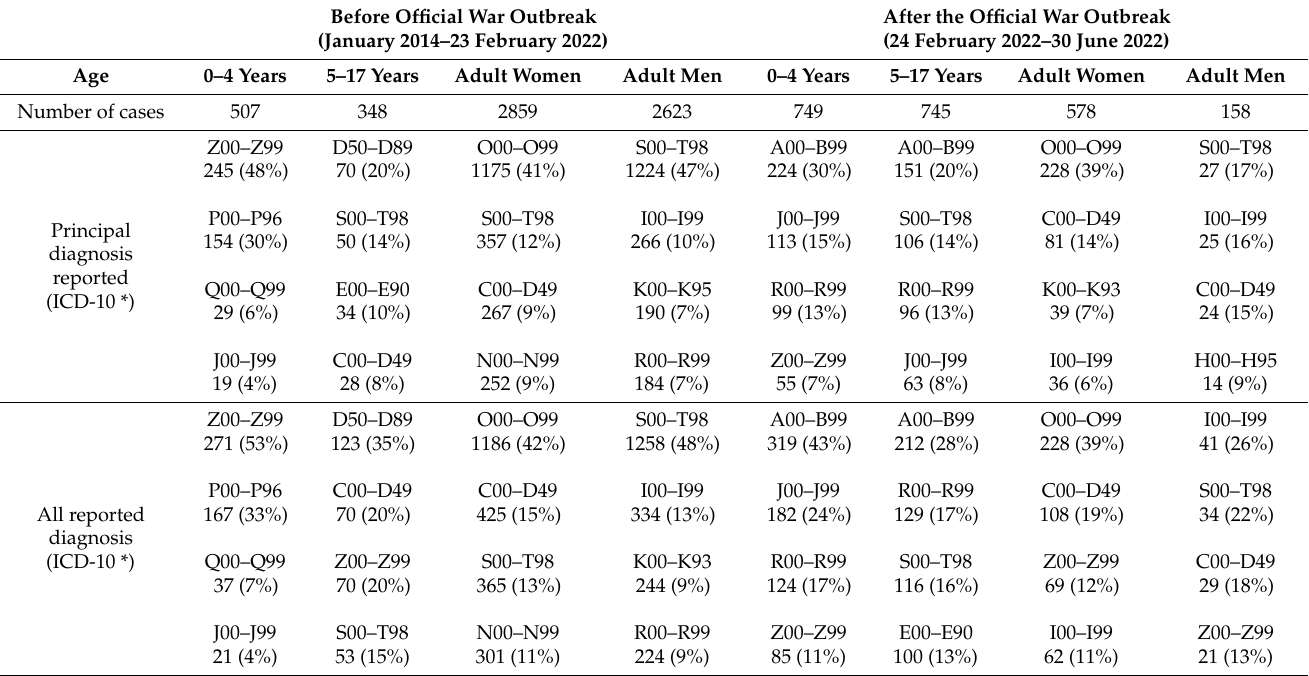
Table 1. Number and percentage of main hospitalization diagnoses in the study